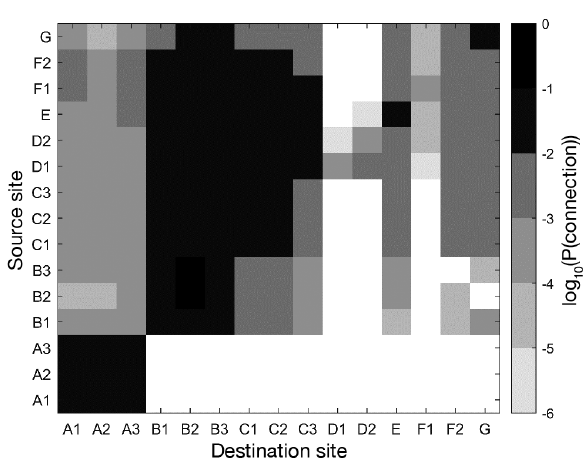
Fig. 6. Connectivity matrix for farm sites in the study domain, predicted using a biophysical model. Pairwise connection probability (P(connection)) on a log 10 scale is shown between sites ordered clockwise around the bay, highlighting values over 0.01 (−2 on log 10 scale), above which population models predict that unmanaged lice abundances would be able to